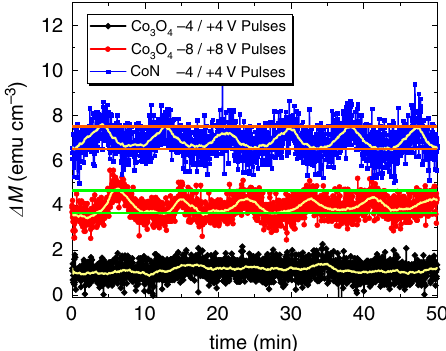
Fig. 2 Cyclability. Magneto-ionic cyclability of the Co 3 O 4 and CoN fi lms subjected to – 4 V/ + 4 V and – 8 V/ + 8 V, and to – 4 V/ + 4 V, respectively, with pulses of short duration ( ≈ 8.5 min/cycle). The pale yellow lines represent the average curves. Horizontal lines (red, green) are guides to the eye and span 1 emu cm − 3 . The data are shifted in Δ M-axis to make them distinguishable. Cyclability was carried out under the application of 5 kOe to ensure being above the anisotropy fi eld and, thus, in